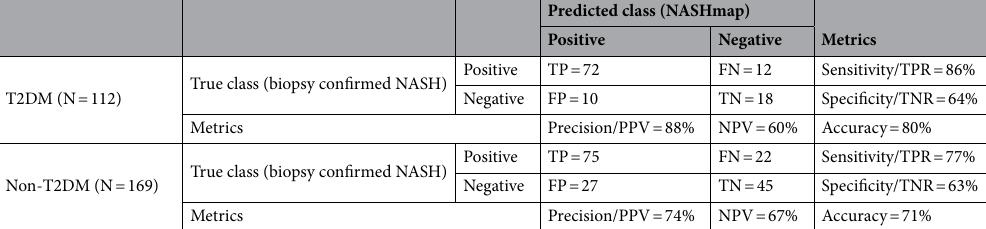
Table 3. Performance of NASHmap in classifying patients in the NIDDK cohort stratified by T2DM status. Accuracy: TP + TN/(TP + FP + FN + TN); FN: false negative; FP: false positive; NIDDK = National Institute of Diabetes and Digestive Kidney Diseases; NASH = nonalcoholic steatohepatitis; NPV: negative predictive value (TN/[FN + TN]); PPV: positive predictive value (TP/[TP + FP]); TN: true negative; TNR: true negative rate (TN/[FP + TN]); TP: true positive; TPR: true positive rate (TP/[TP + FN]).